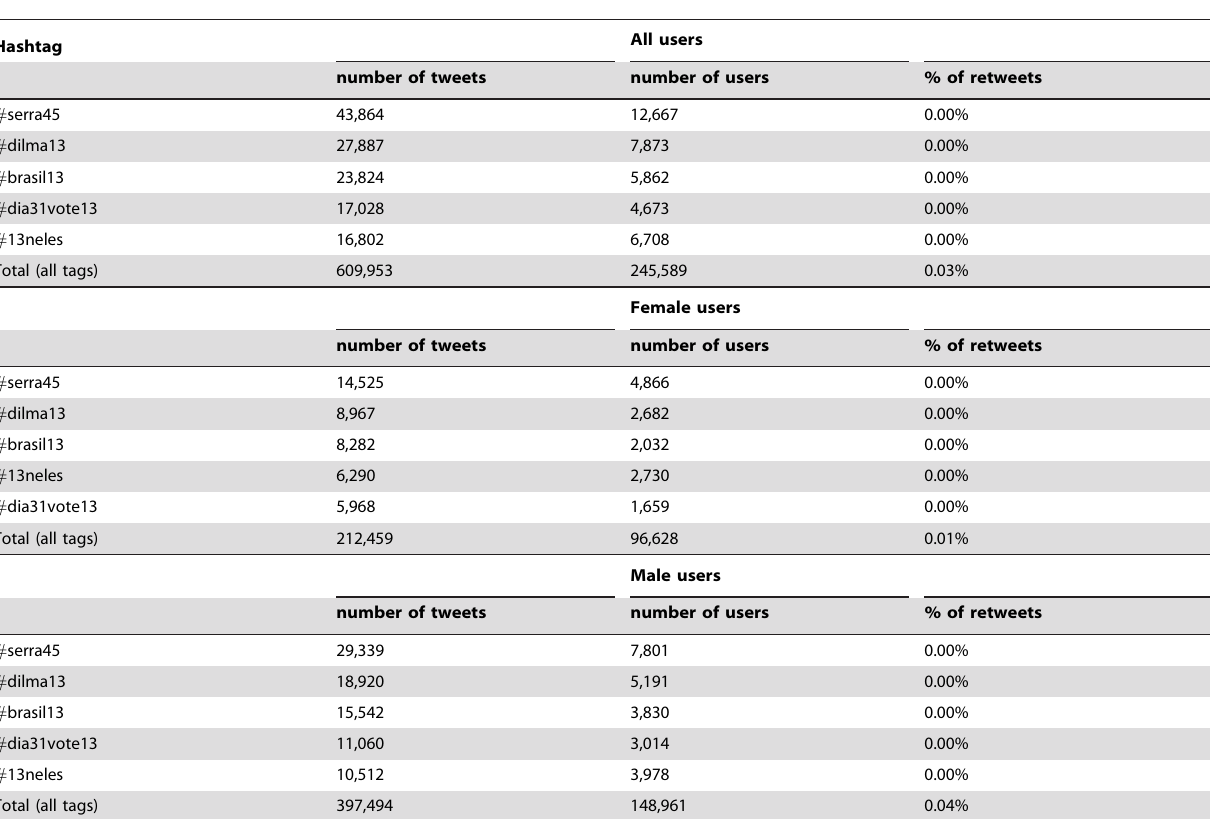
Table 2 Information on the most frequent hashtags of the